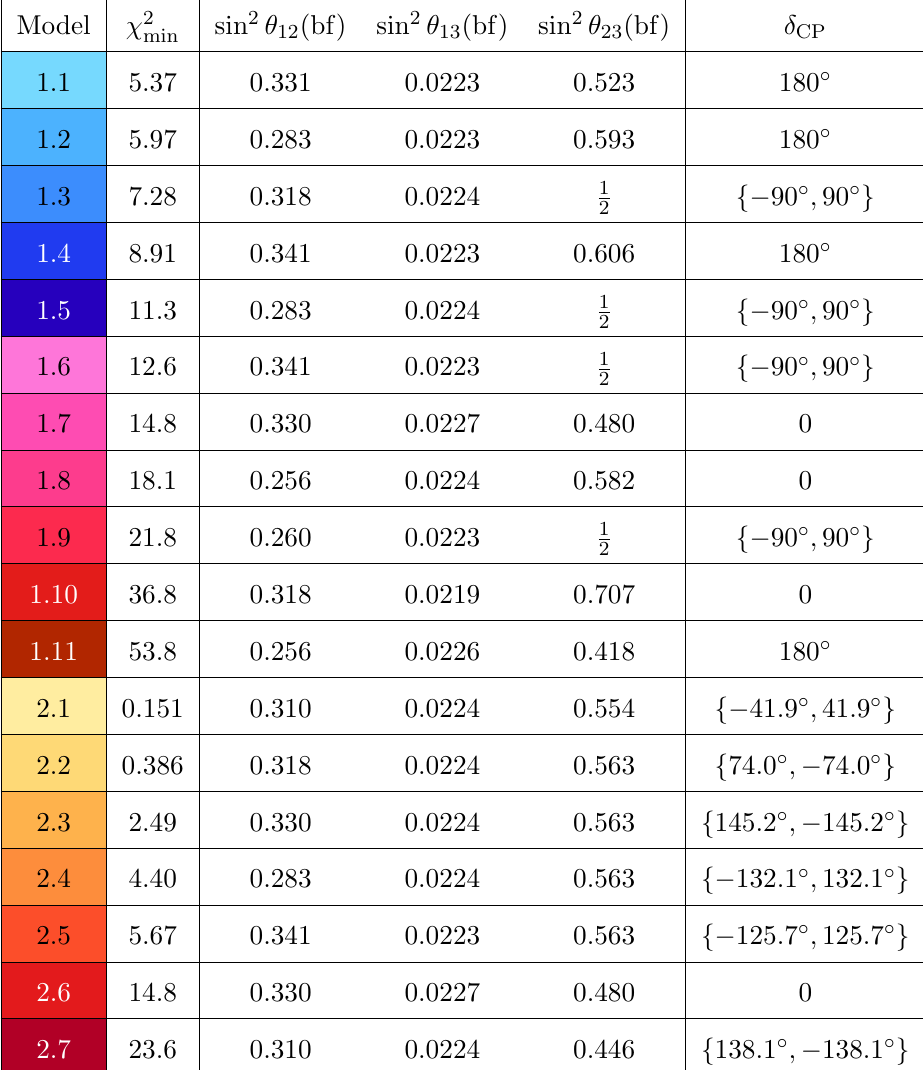
Table 9 . Best-(cid:12)t values of leptonic mixing parameters sin 2 (cid:18) 12 (bf), sin 2 (cid:18) 13 (bf), and sin 2 (cid:18) 23 (bf) for the 18 one- and two-parameter models (including the predicted values of (cid:14) CP for each model), using the best-(cid:12)t values of the model parameters given in table 8. Note that for the models that predict (cid:14) CP (cid:14) 1 ; (cid:14) 2 , (cid:14) 1 corresponds to the (cid:12)rst presented best-(cid:12)t point in table 8 with (cid:18) bf < 90 (cid:14) 2 f g